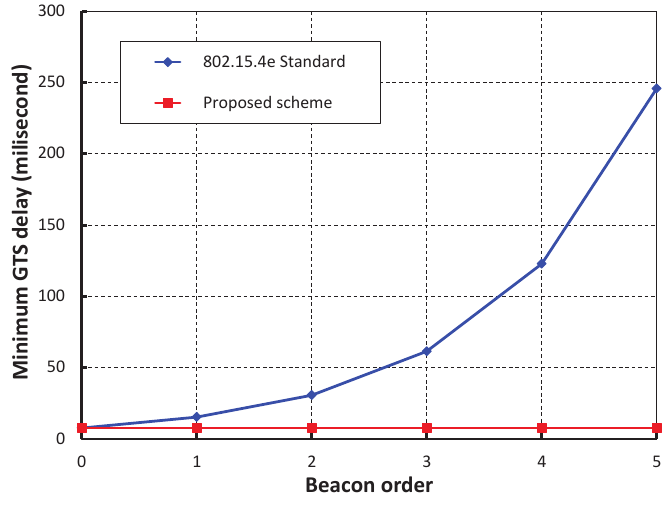
Figure 14. Comparison of GTS retransmission delay of our scheme with IEEE 802.15.4e